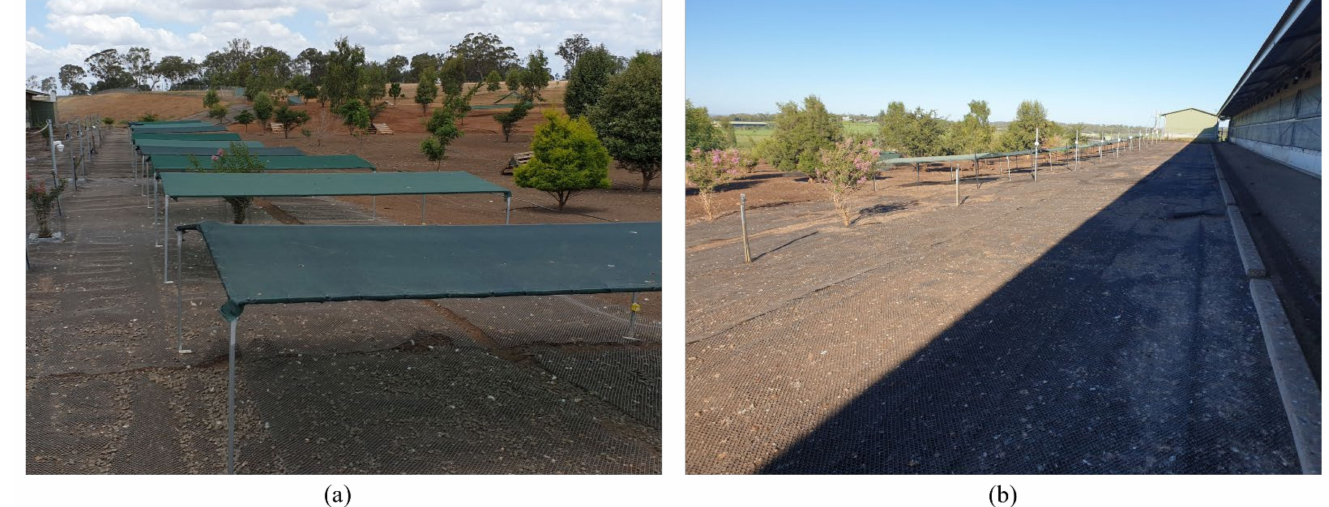
Figure 1. Experimental set-up in two different sheds of a commercial free-range farm: ( a ) Flock-A, and ( b )